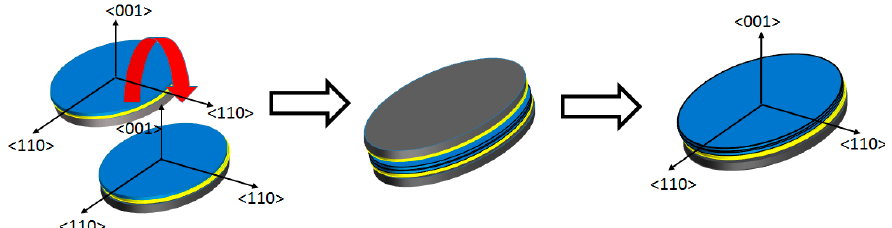
Figure 26. Schema of the wafer bonding process. Two <100>-oriented SOI wafers are used ( left ), where the blue color characterizes the thin device layer (30 nm thick), yellow the buried oxide and grey the substrate wafer. Both wafers are stuck (bonded) together, so that the surfaces of both device layers are in contact ( middle ). A new SOI wafer results after removing one of the original substrate wafers ( right ). The thickness of the device layer is now 60 nm.